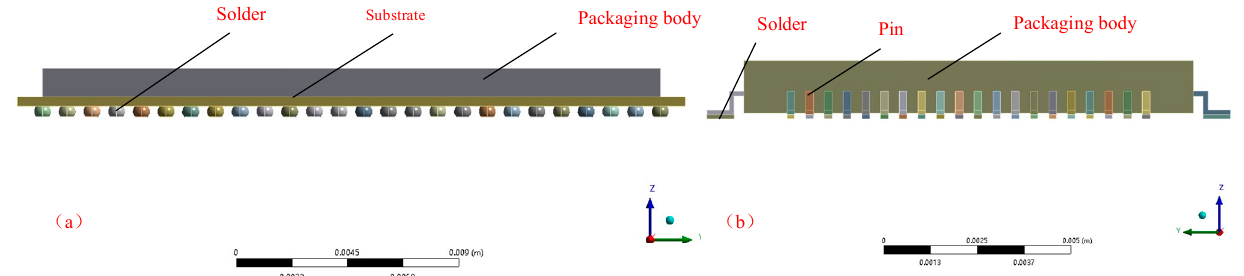
Figure 5. The 3D finite element model.